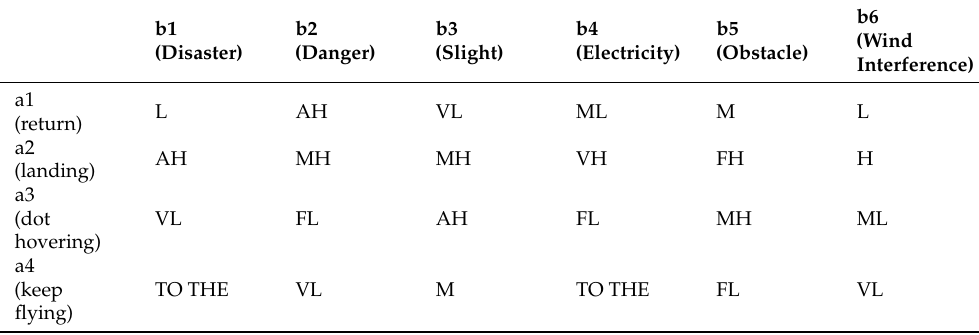
Table 3. Initial decision matrix expressed by language